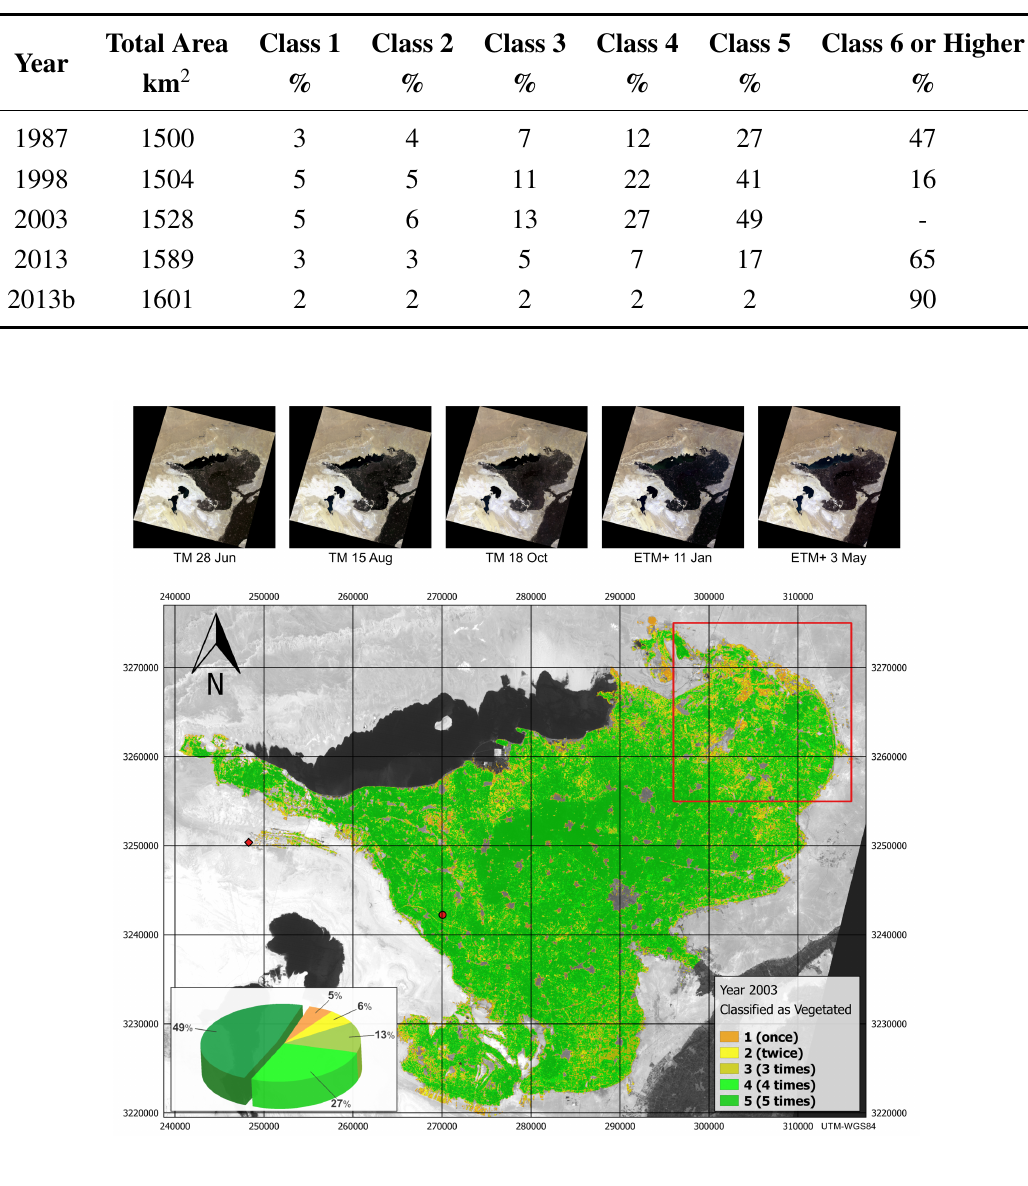
Figure 6. Aggregated classification of the 2003 Landsat series. The series is composed of ten images acquired on five different dates. All the coloured pixels are classified as vegetated and the class number indicates how many times the pixel has been classified as vegetated. The pie-chart shows the areal percentage of each class. The red polygon delimits the area where the accuracy assessment was performed. The red circle and the diamond indicate the positions of the two pixels of Figure